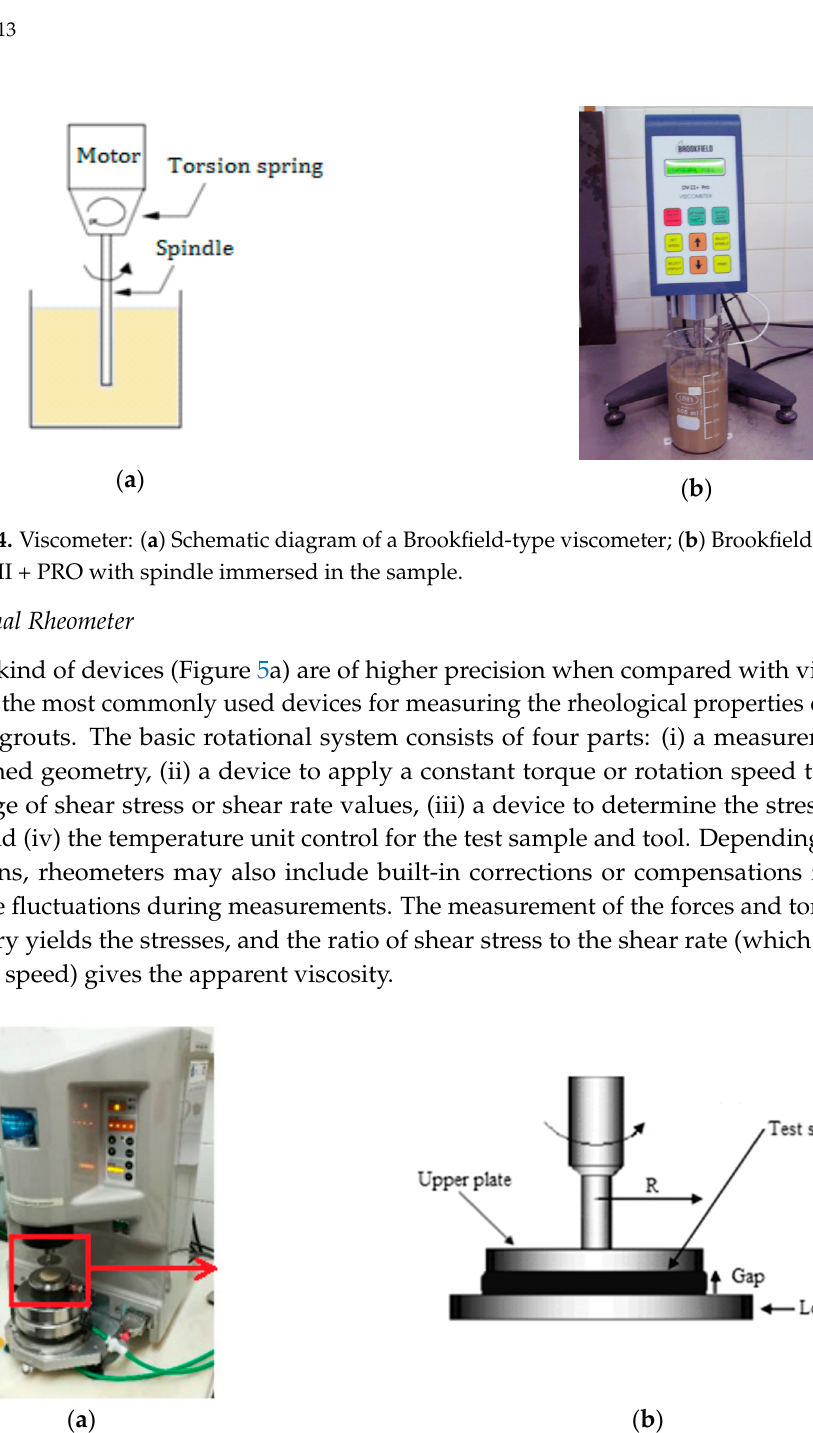
Figure 5. Rheometer: ( a ) Rotational rheometer; ( b ) Illustration of parallel plates geometry.